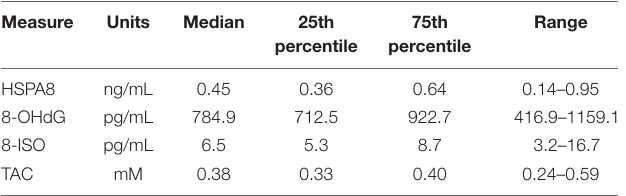
TABLE 1 | Summary statistics for HSPA8, 8-OHdG, 8-ISO, and total antioxidant capacity (TAC) concentrations in CSF from 34 healthy subjects.